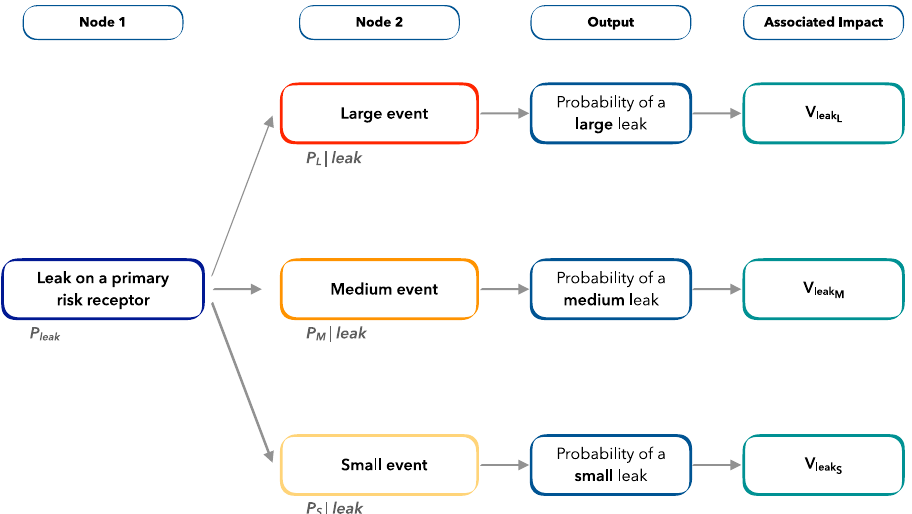
Figure 13. Basic template of the event tree defined for assessing impacts on primary risk receptors for Phase 1: Site construction and drilling.